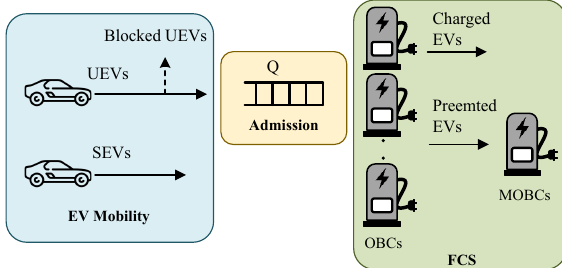
Figure 3. Proposed operating mechanism of the FCS